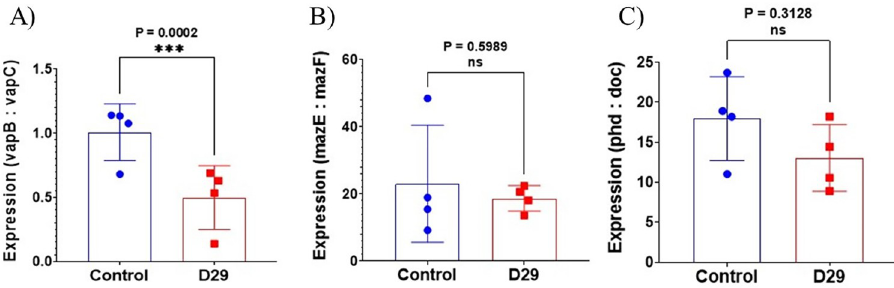
Fig 7. Analysis of TA system gene expression with or without (control) D29 infection for 2h by qRT-PCR. The systems examined are A), VapBC, B), MazEF, C) phd/doc. The expression level of each gene was determined by the comparative C T method after normalizing with a 16S rRNA control. The results of the qRT_PCR experiments are expressed as ratios between the anti-toxin and toxin components. The results are presented as the average of four biological repeat experiments ± S.D. The significance levels (p values) are mentioned and marked with asterix. Non- significant results are marked (ns). The agarose gel electrophoresis analysis of the products (one set) are shown in S3 Fig.